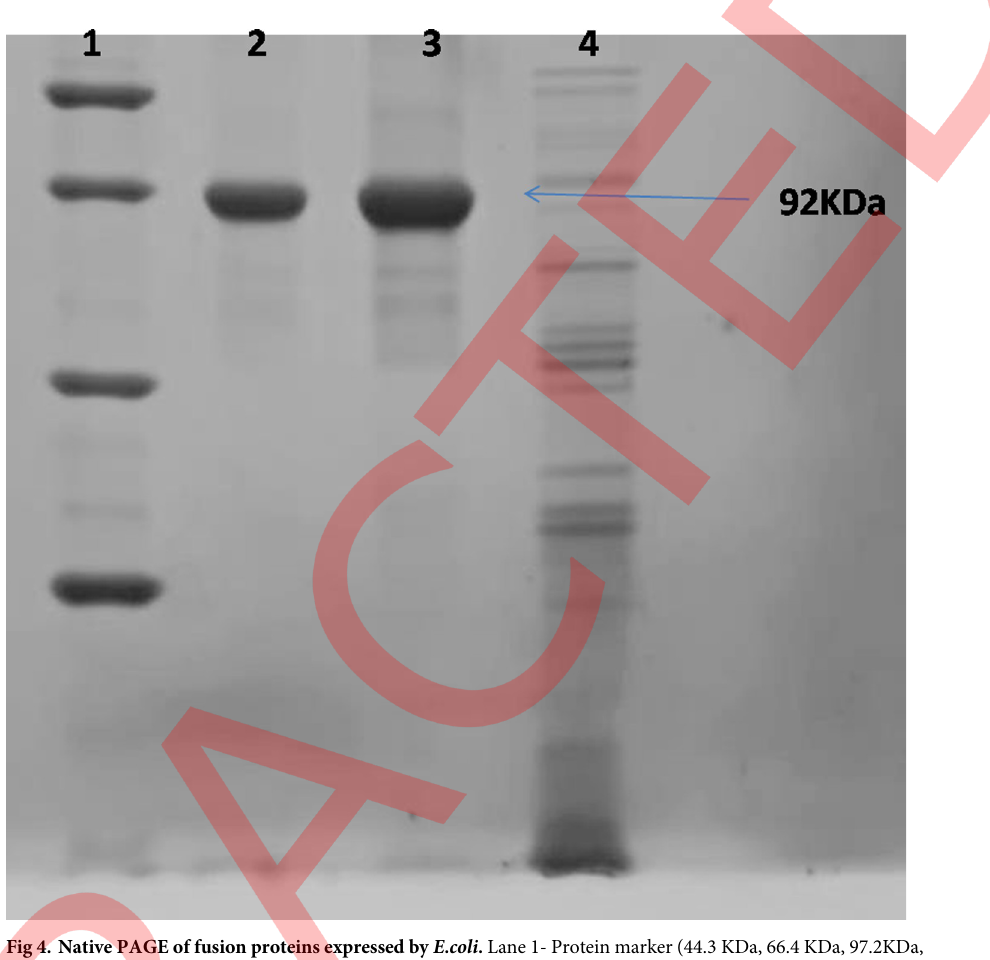
Fig 4. Native PAGE of fusion proteins expressed by E . coli . Lane 1- Protein marker (44.3 KDa, 66.4 KDa, 97.2KDa, 116 KDa, and 200 KDa), Lane 2- Sample purified using Ni-NTA column without IPTG induction; Lane 3-Sample purified using Ni-NTA column with IPTG induction; Lane 4- Crude protein without insert. Proteins were resolved on the 12.5% PAGE with standard molecular weight markers. The gel was allowed to run in Tris-glycine buffer at 30 mA constant current for 2.5 h followed by staining with Coomassie Brilliant Blue R-250. The molecular weight of the separated proteins was determined by comparing them with molecular weight standards.